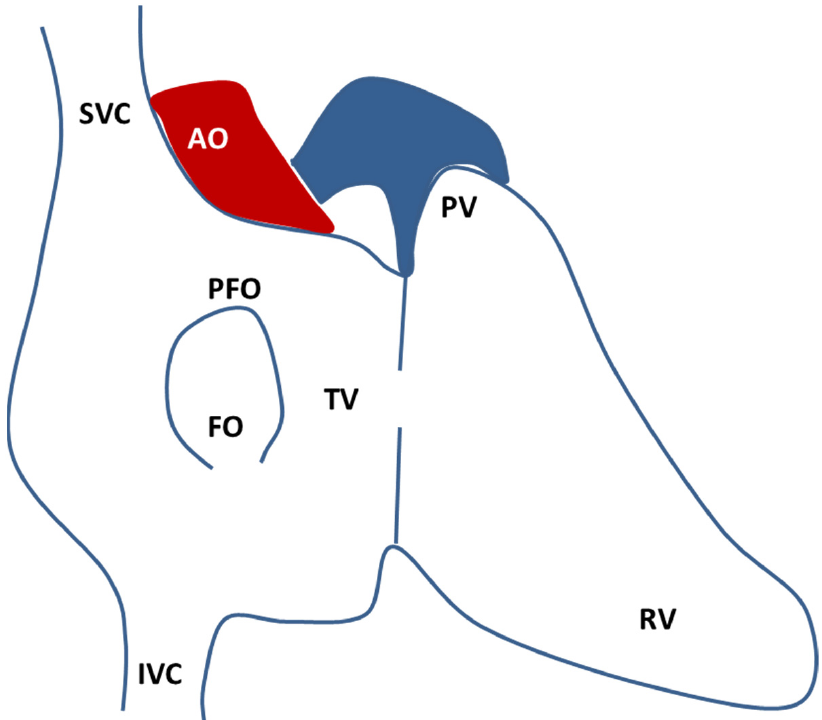
Figure 1. Schematic drawing of the atrial septal anatomy seen from the right atrium (redrawn from Calvert, P., Rana, B., Kydd, A. et al. Patent foramen ovale: anatomy, outcomes, and closure. Nat Rev Cardiol 8, 148–160 (2011). https://doi.org/10.1038/nrcardio.2010.224 accessed date 28 October 2021.). The fossa ovalis (FO) is composed by the septum primum and the septum secundum and the usual location of the PFO is on the anterosuperior border of the FO. AO, aorta; FO, fossa ovalis; IVC, inferior vena cava; PFO, patent foramen ovale; PV, pulmonary valve; RV, right ventricle; SVC, superior vena cava; TV, tricuspid valve.